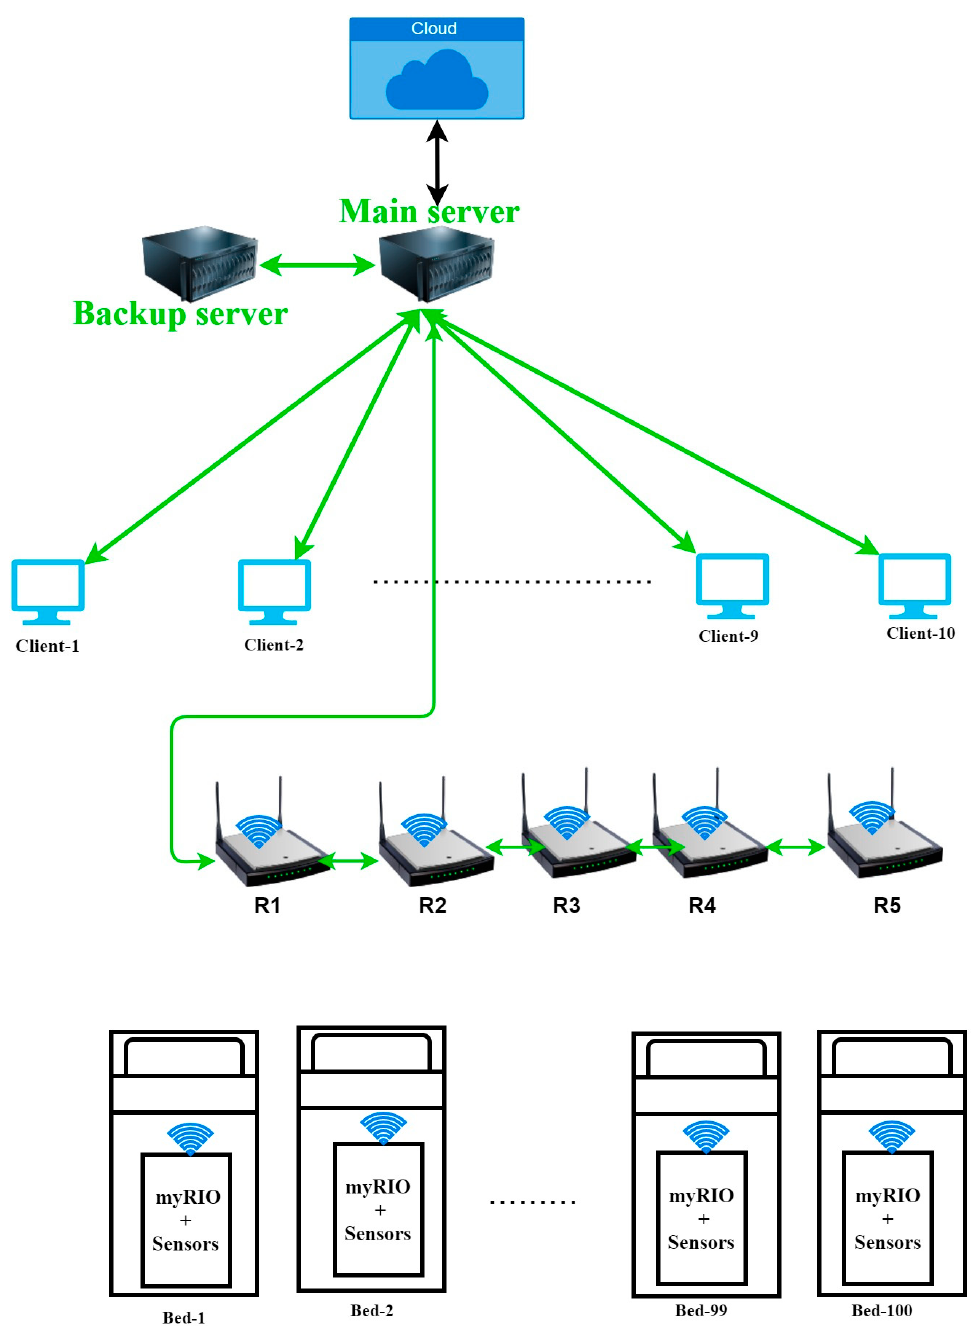
Figure 8. Networking configuration.